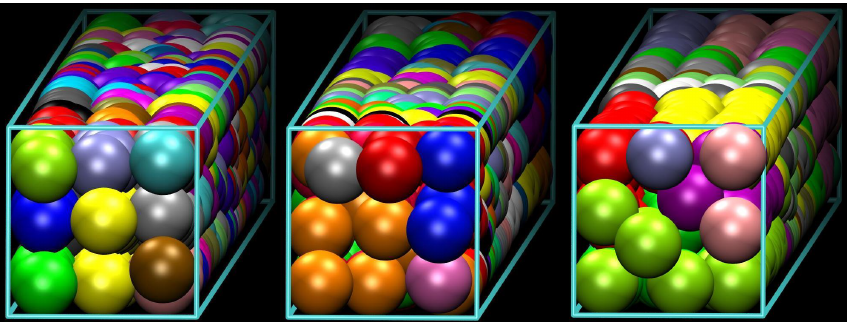
Figure 2. Same as in Figure 1 but for cross-sectional views. From left to right: chains consist, on average, of N = 7, 17 and 35